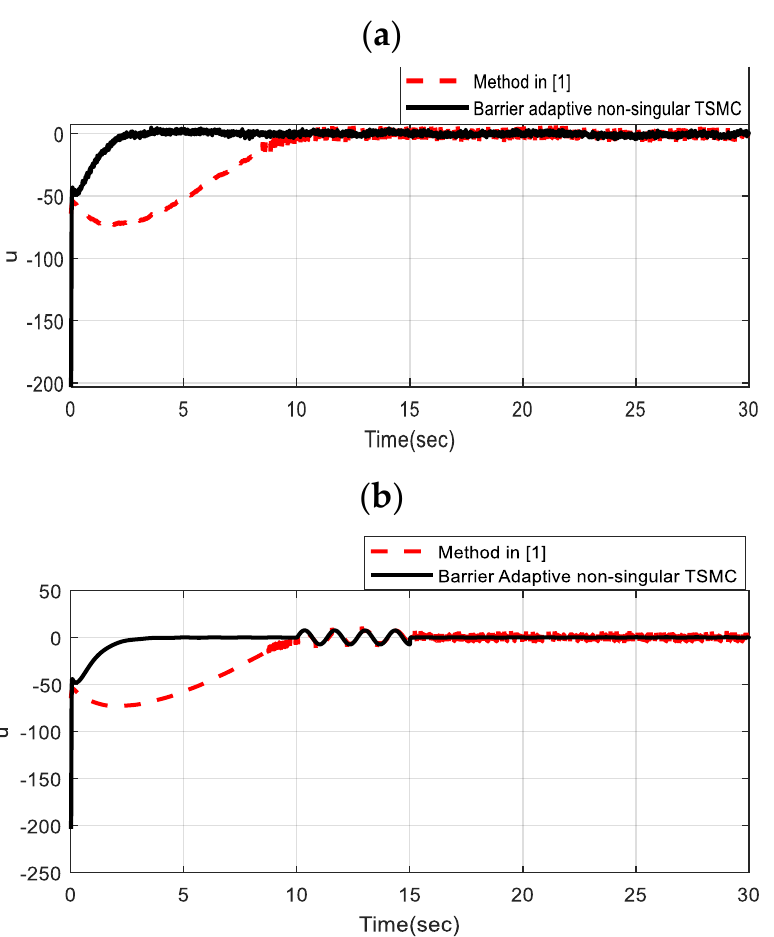
Figure 10. Trajectory of control inputs ( a ) with noise ( b ) in the presence of an abrupt change in disturbance.